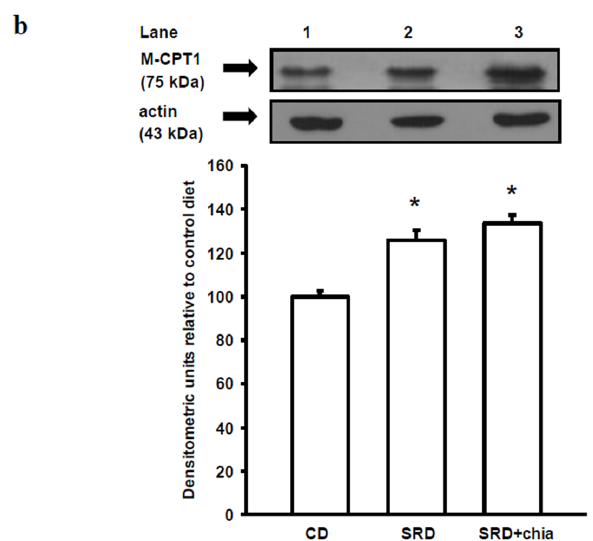
Values are mean, with their standard errors depicted by vertical bars (six animals per group) and expressed as percentage relative to the control diet. * p < 0.05 SRD and SRD + chia vs . CD. Figure 3. ( a ) Heart enzyme activities of M ‐ CPT1 and CPT2 in rats fed a control diet (CD), sucrose ‐ rich diet (SRD) or SRD+chia seed (SRD+chia). Values are expressed as mean ± SEM (six animals per group). Values in a line that do not share the same superscript letter ( a , b , c ) are significantly different ( p < 0.05) when one variable at time was compared by the Newman Keul`s test; ( b ) Top panel: a representative immunoblot of heart M ‐ CPT1 protein mass level of rats fed CD, SRD and SRD + chia. Molecular marker is shown on the right. Lane 1, CD; lane 2, SRD; lane 3, SRD + chia. Bottom panel: densitometric immunoblot analysis of heart M ‐ CPT1 protein mass level of rats fed CD, SRD or SRD + chia.